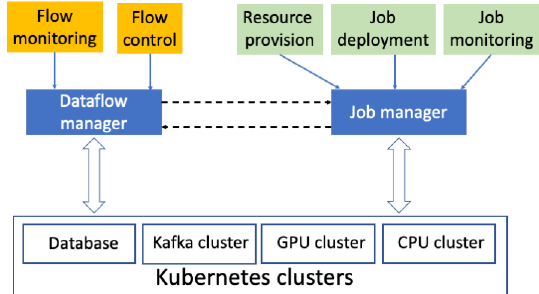
Figure 6. The workflow developed for the coupling and deployment of the Flood-PREPARED real-time nowcasting